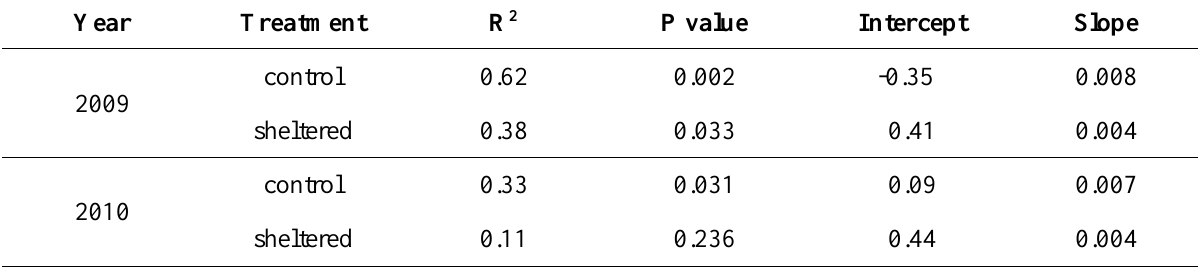
Table 1: Regression analysis of soil CO 2 efflux (µmol m -2 s -1 ) versus water table depth (cm) in 2009 and 2010 in the control and sheltered